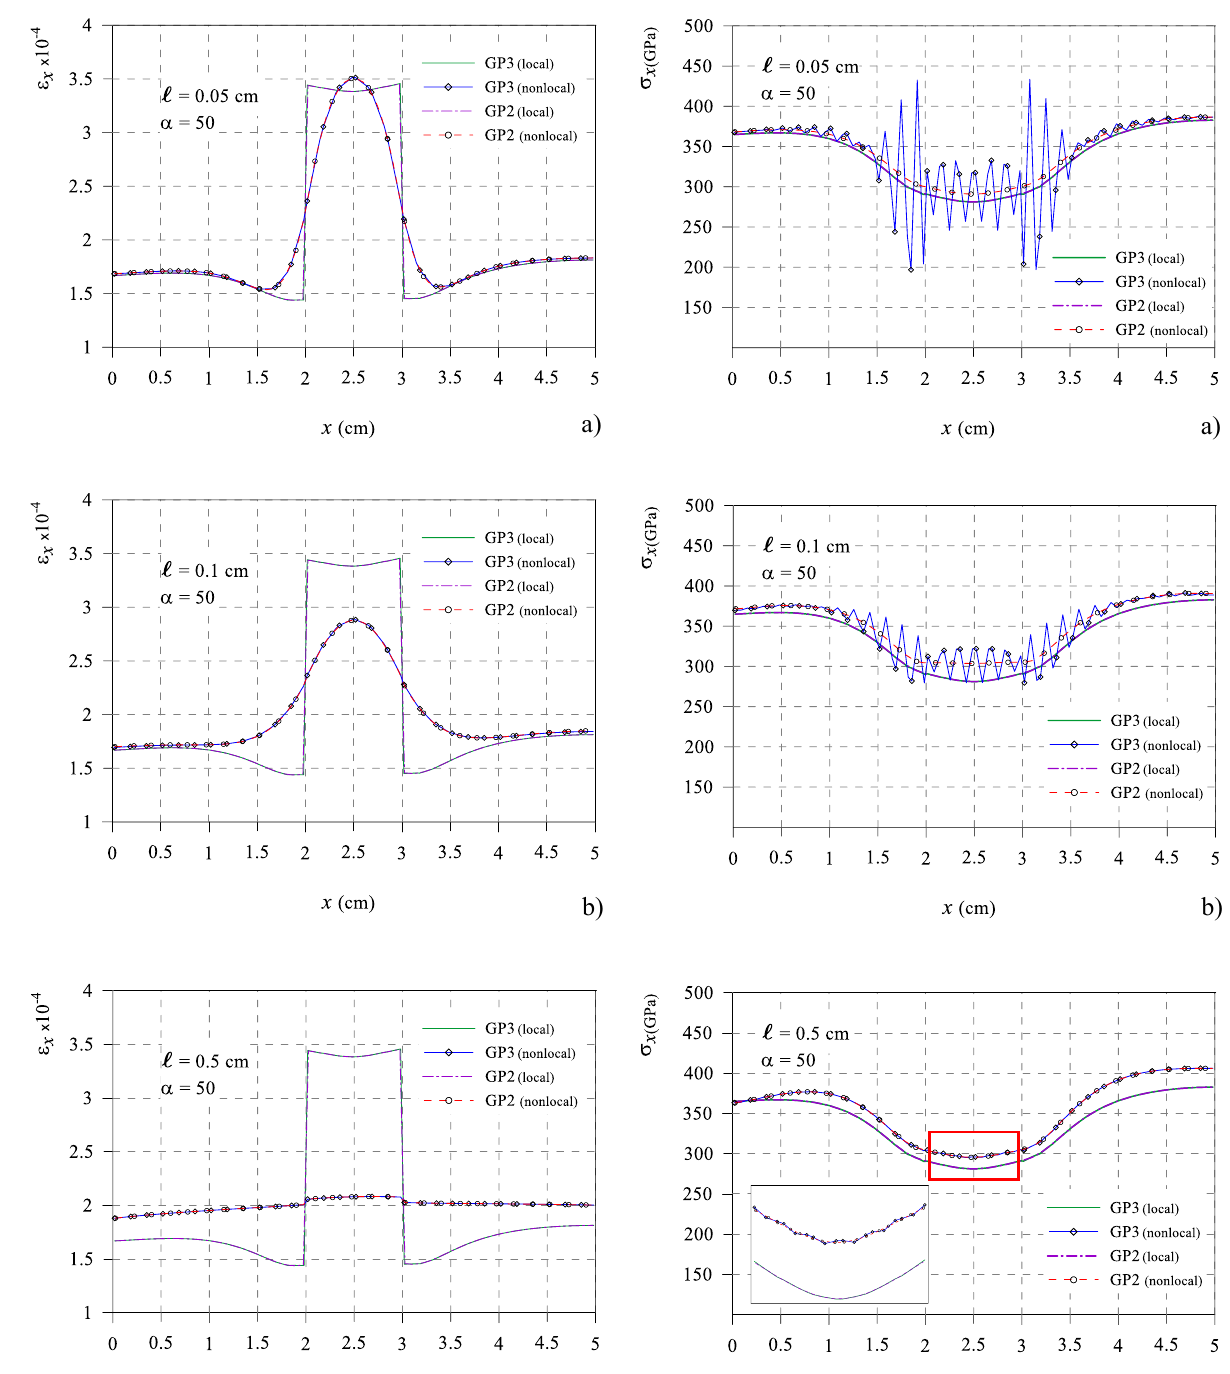
Figure 7: Local and nonlocal stress profiles σ x , obtained with full (GP3 curves) and reduced (GP2 curves) integration for the plate of Figure 5, at the mid section y=2.5a : a ) for ℓ = 0.05 ; b ) for ℓ = 0.1 ; c ) for ℓ = 0.5